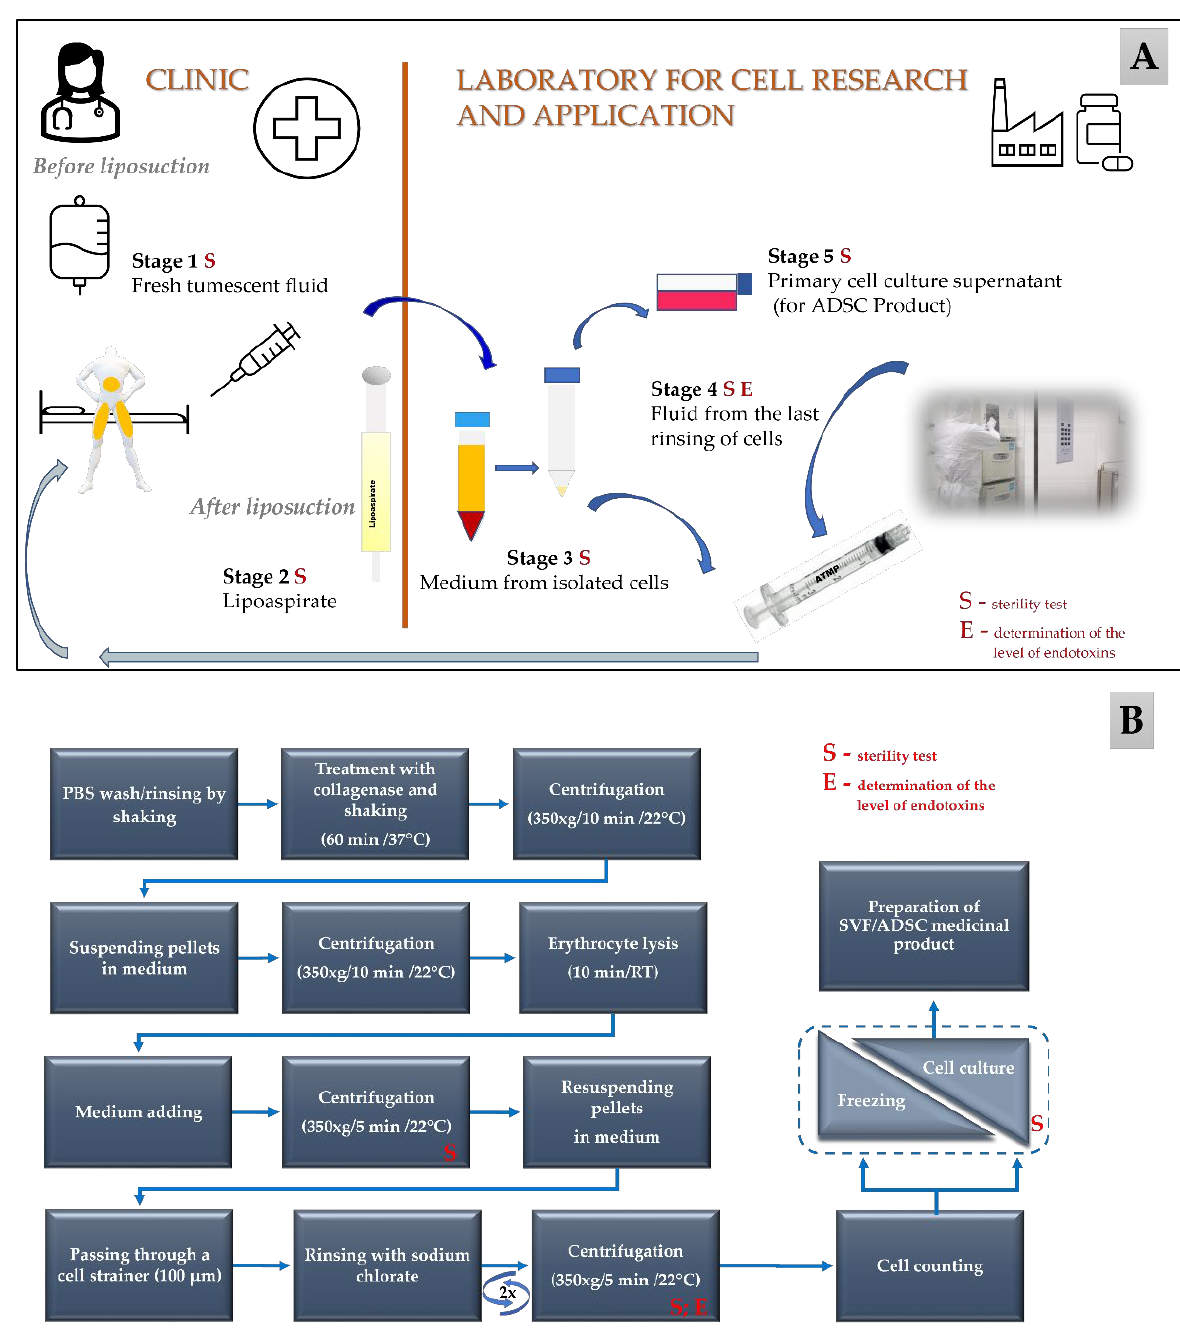
Figure 1. Subsequent stages of the procedure, from the collection of the starting material to the production of ATIMP; ( A ) overall schema of the whole process; ( B ) detailed manufacturing steps in the laboratory. The sampling points for sterility and endotoxin tests are marked with the letters S and E, respectively.